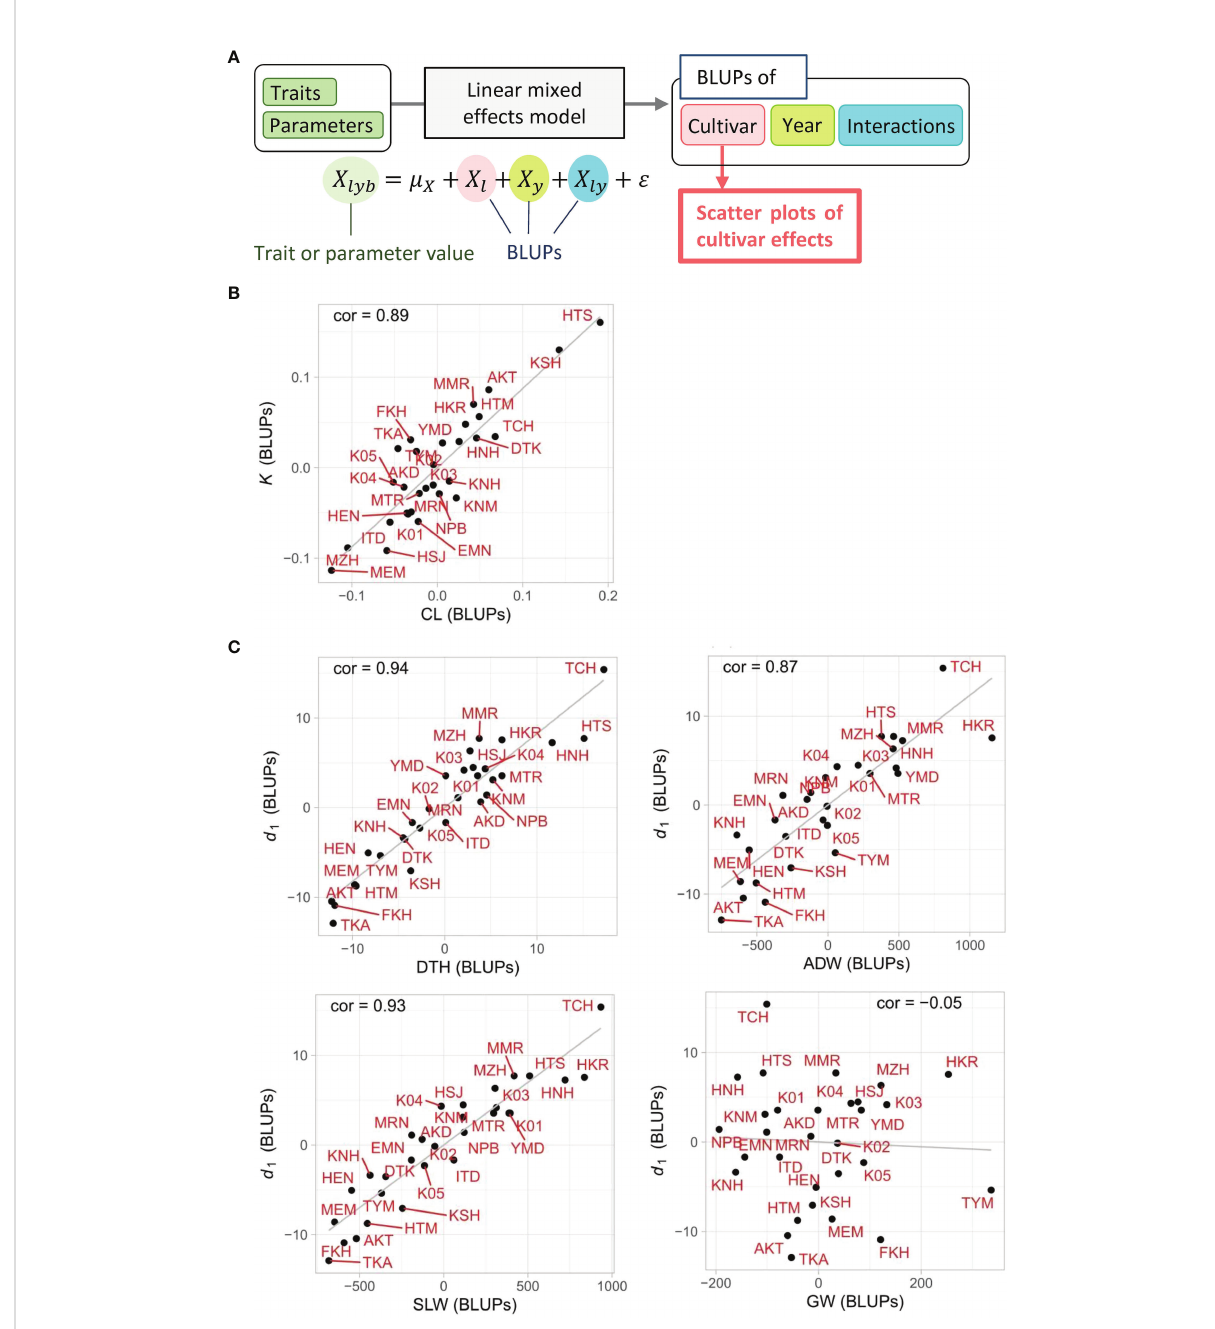
FIGURE 7 Scatter plots of cultivar effects between CH-related parameters and manually measured traits. (A) Flow chart of the process to generate scatter plots. The cultivar effect ( X l ) on traits and parameters was extracted from the linear mixed effects model as BLUPs from the 3-year experiment. (B, C) Plots of cultivar effects showing correlations between (B) K and CL and between (C) d 1 and DTH, ADW, SLW, or GW. Correlation coef fi cients (cor) are shown in plots. Cultivar name codes are shown in